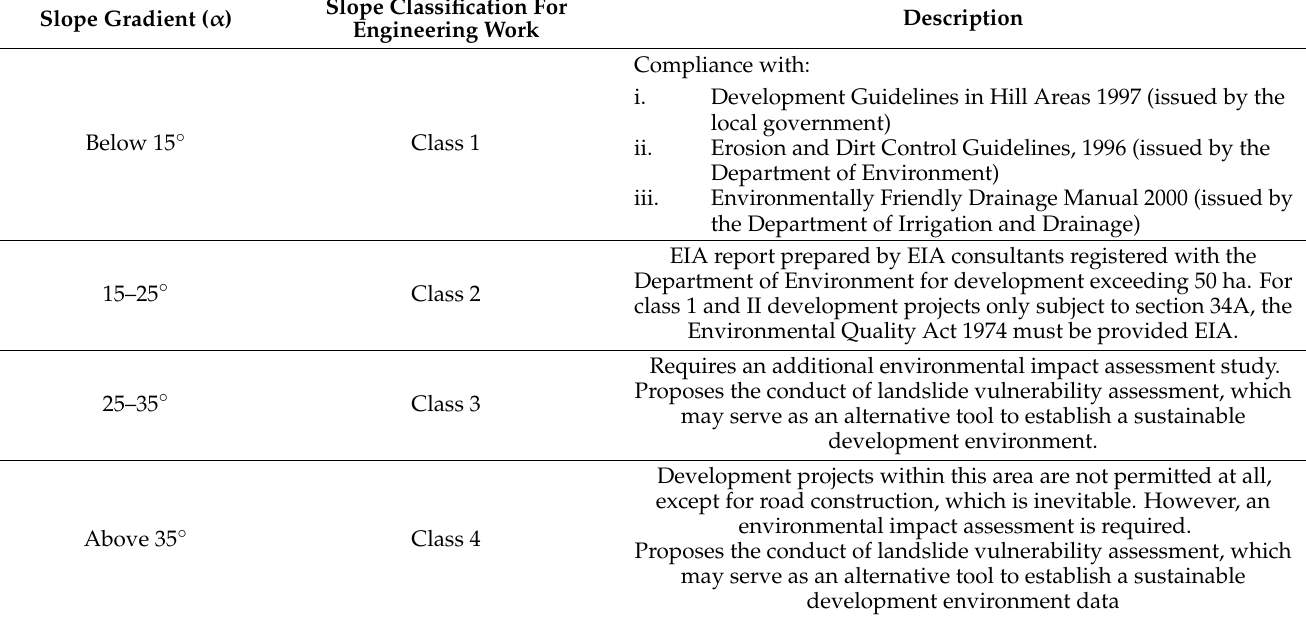
Table 2. Malaysian Guideline on physical development in hilly